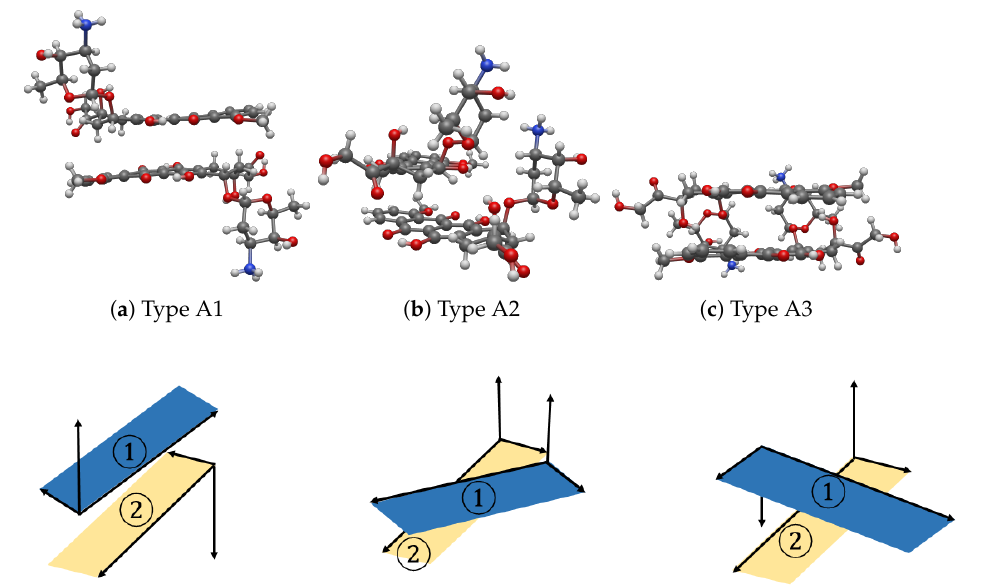
Figure 3. Three stable configurations (first row) and their corresponding vector representations (second row) for interactions between two DOXHs of ( a ) Type A1, ( b ) Type A2 and ( c ) Type A3 where 1 (cid:13) and 2 (cid:13) indicate two carbon planes.